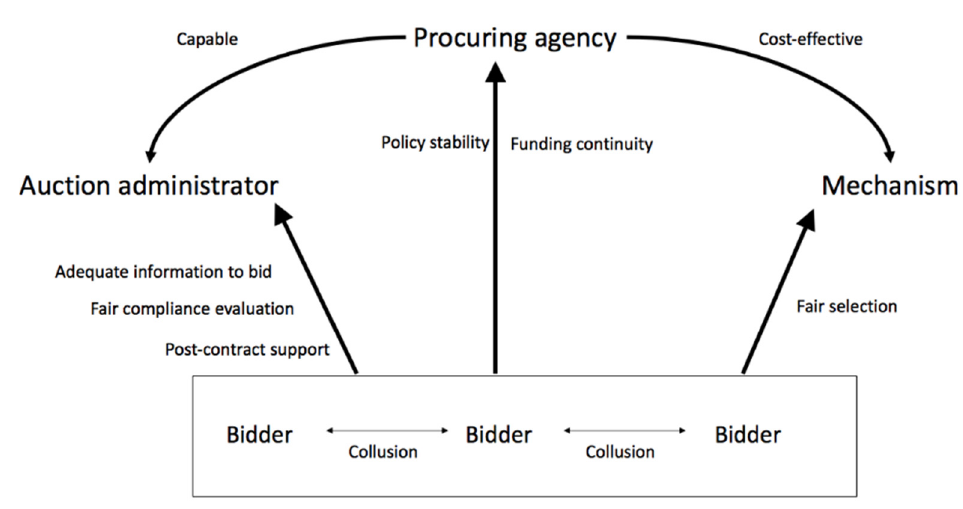
Figure 5. Potential trust relationships between reverse auction actors. Arrows move from truster to trustee.